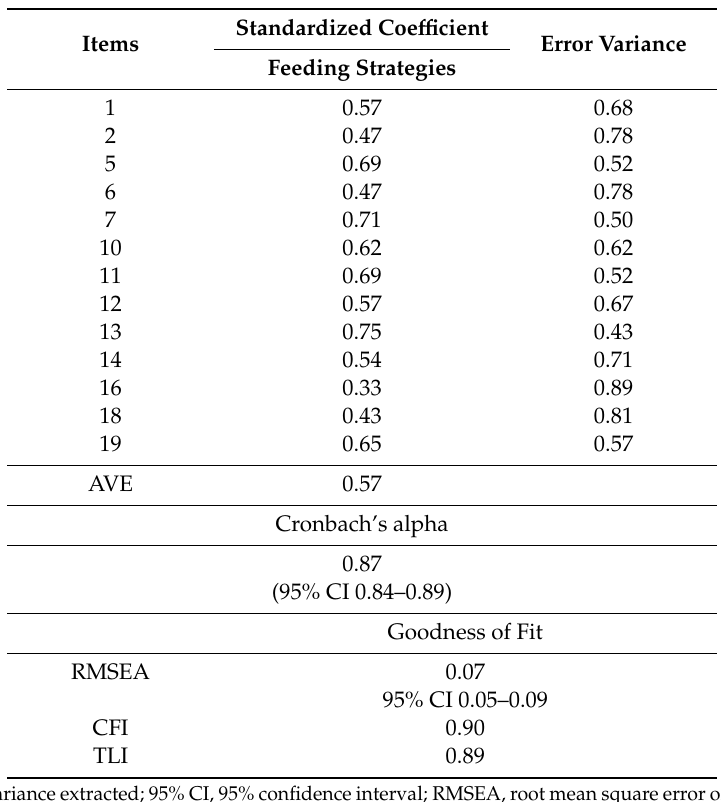
Table 4. Standardized coe ffi cient of the 13 items (one-dimensional structure) by structural equation model, error variance, and Cronbach’s alpha of the Brazilian (Rio de Janeiro) final version of the CFSQ, Rio de Janeiro, Brazil,